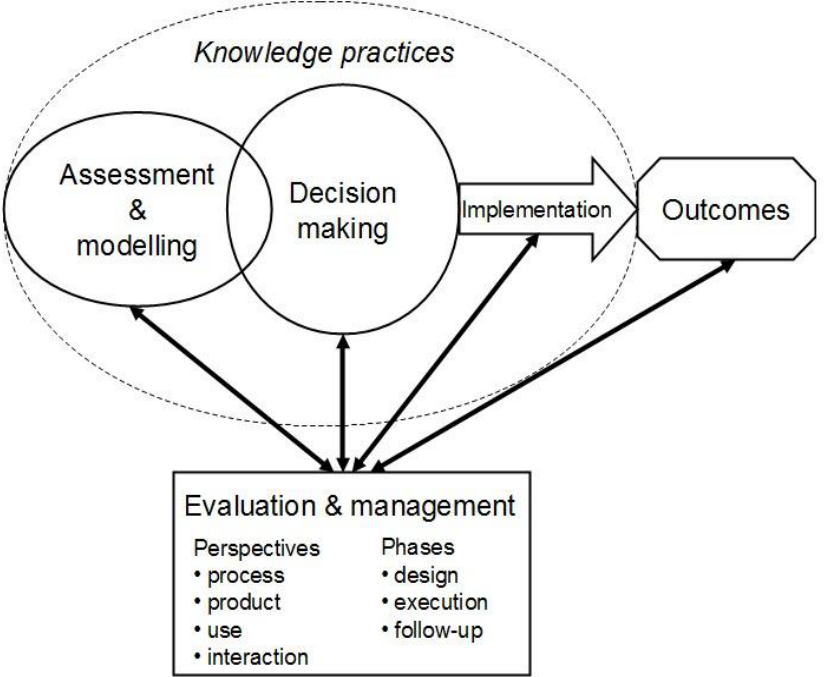
Figure 2. A framework for comprehensive evaluation and management of assessment and model performance. The chain from assessment and modeling to outcomes mostly consists of production, communication and application of knowledge in a societal